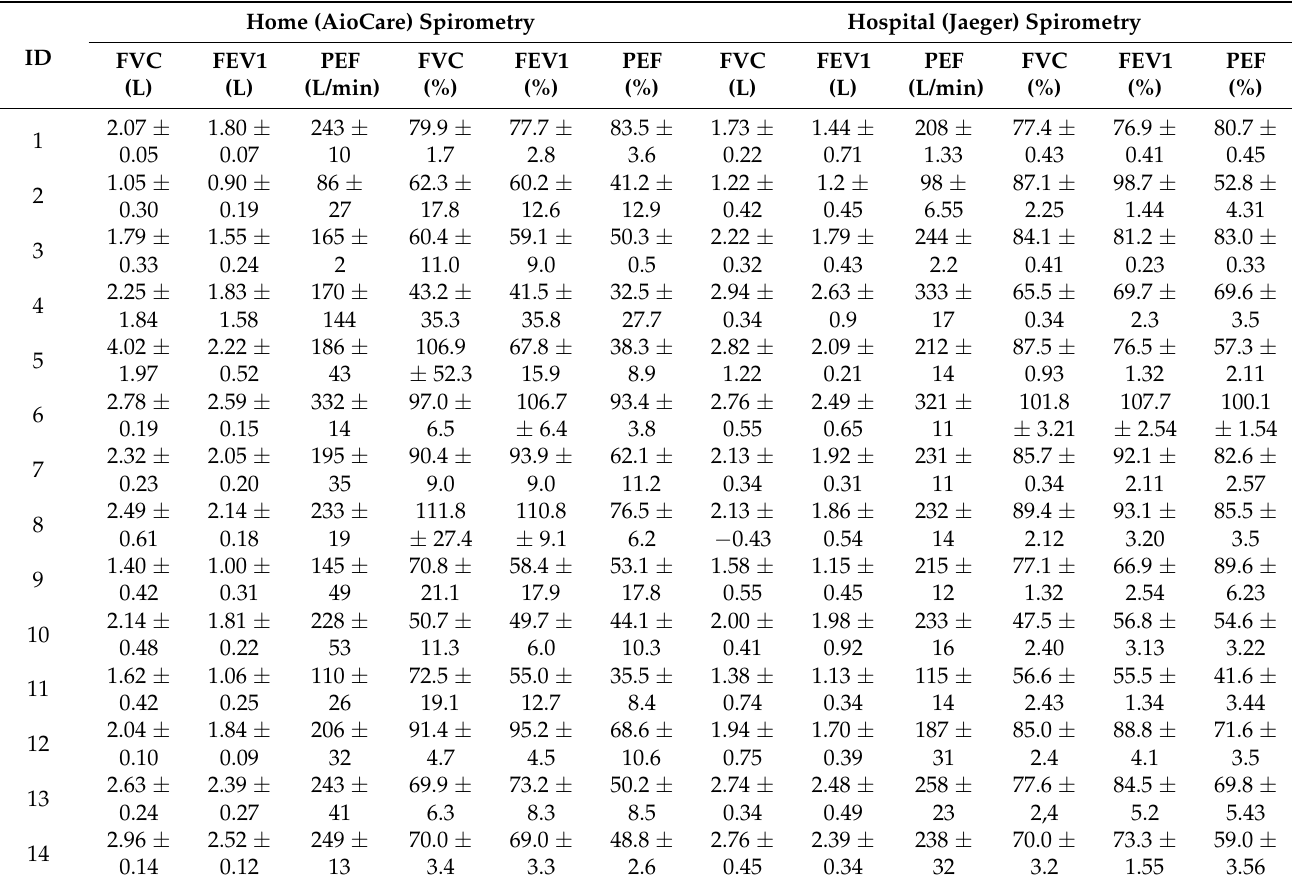
(Table 4). Moderate-to-high correlation between values of home and hospital spirometry was observed (Table 4). Table 3. Individual patient pulmonary function tests results.